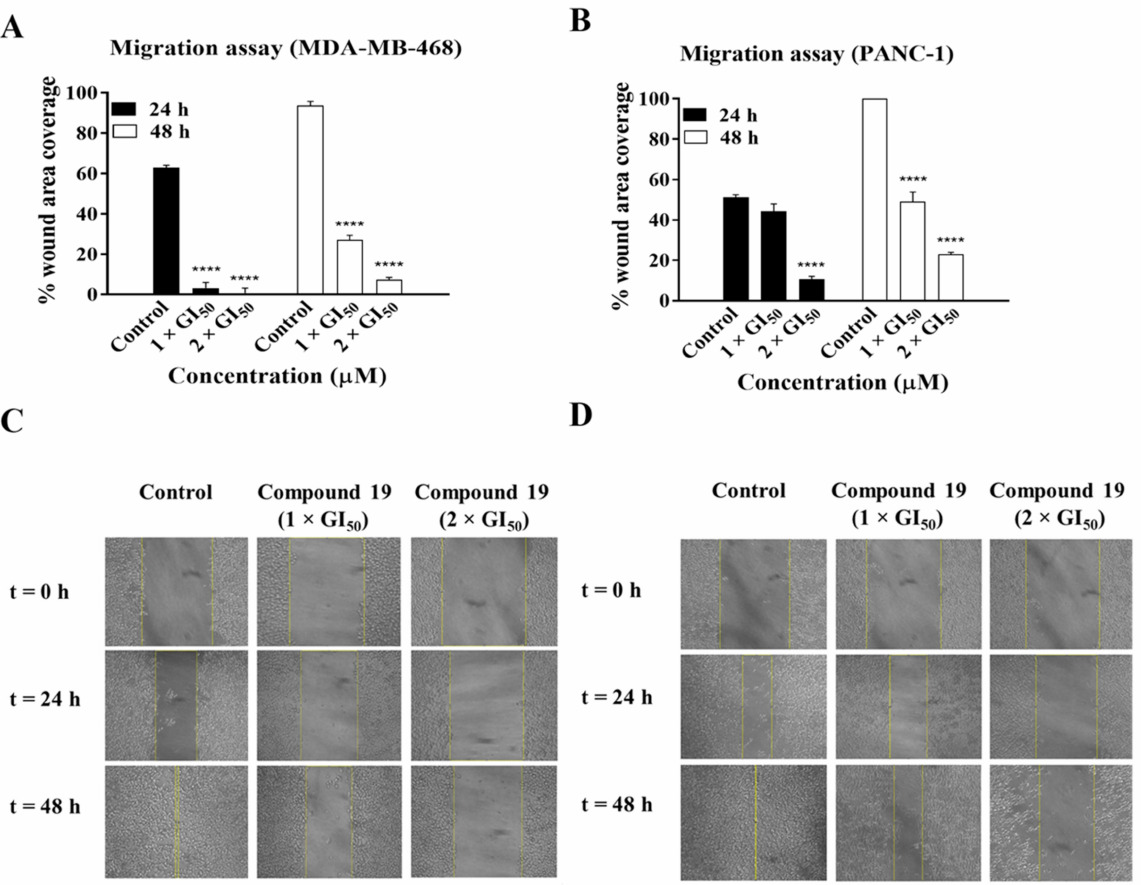
Figure 4. Compound 19 significantly inhibited the migration of MDA-MB-468 and PANC-1 cells after 24 h and 48 h. ( A , B ) The migration assay was conducted by forming a “wound” across a layer of cells followed by treatment with either solvent control or 19 at concentrations of 1 × GI 50 and 2 × GI 50 . Cell migration was calculated and expressed as the percentage of “wound” area covered by the cells to the initial cell-free “wound” area. The assay was repeated at least three times. Bars and error bars refer to the mean ± SD. **** p < 0.0001 vs. control. ( C , D ) Representative microscopic images from one of the migration assay